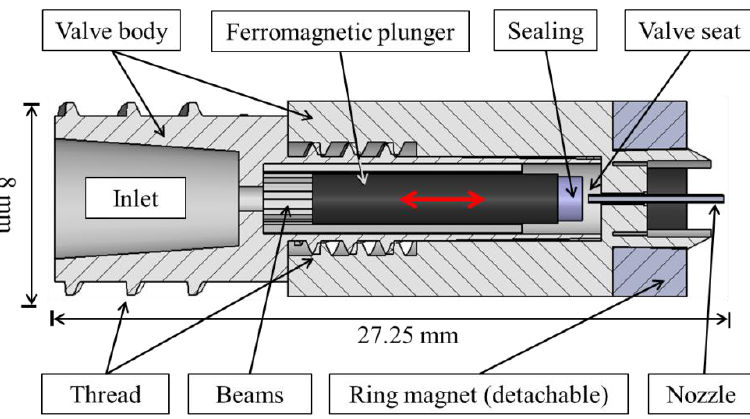
Figure 4. Cross-section through the dispensing valve with the movable plunger (red